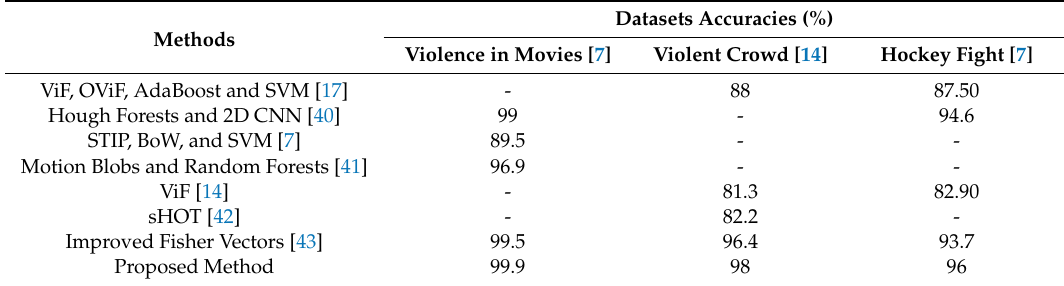
Table 8. Comparative analysis of the proposed method with state-of-the-art methods based on overall